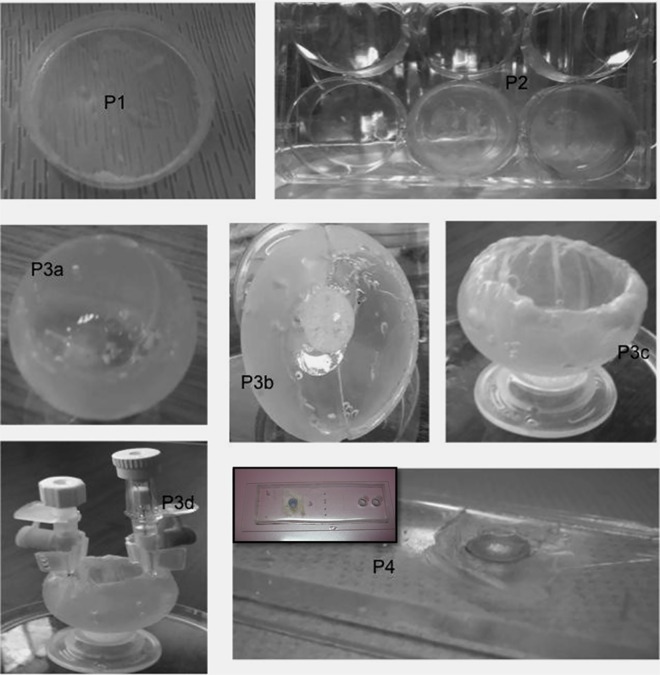
Prototypes of the Biomimetic Platform.Various examples of the prototypes are shown. P1 and P2 are platforms in which regular Petri dishes or well plates lined with hAM were used. P3 shows successive steps of developing a PDMS-hAM platform with an additional fluid dynamic factor (a-d). P4 is a microchip chamber connected with microfluidic channels (inlet and outlet channels), the hAM layer was applied top-down to allow the free flow of media across the chamber.